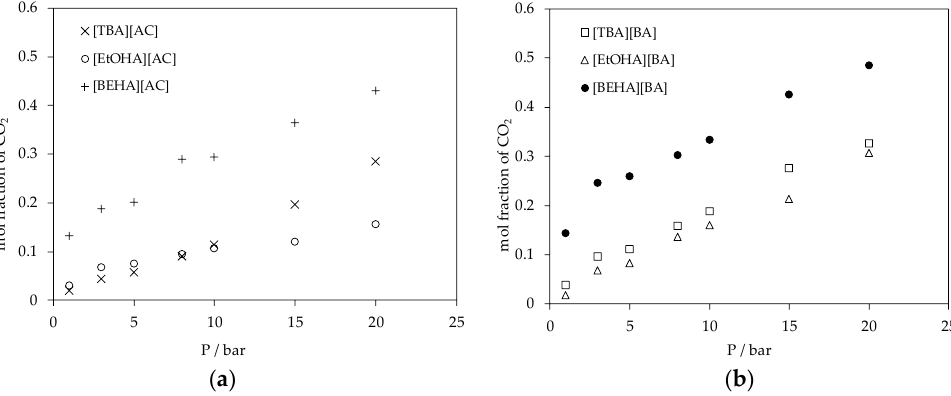
Figure 8. ( a ) Plot of CO 2 absorption in ammonium-based protic ionic liquids with [AC] anion and ( b ) plot of CO 2 absorption in ammonium-based protic ionic liquids with [BA] anion at 298.15 K.